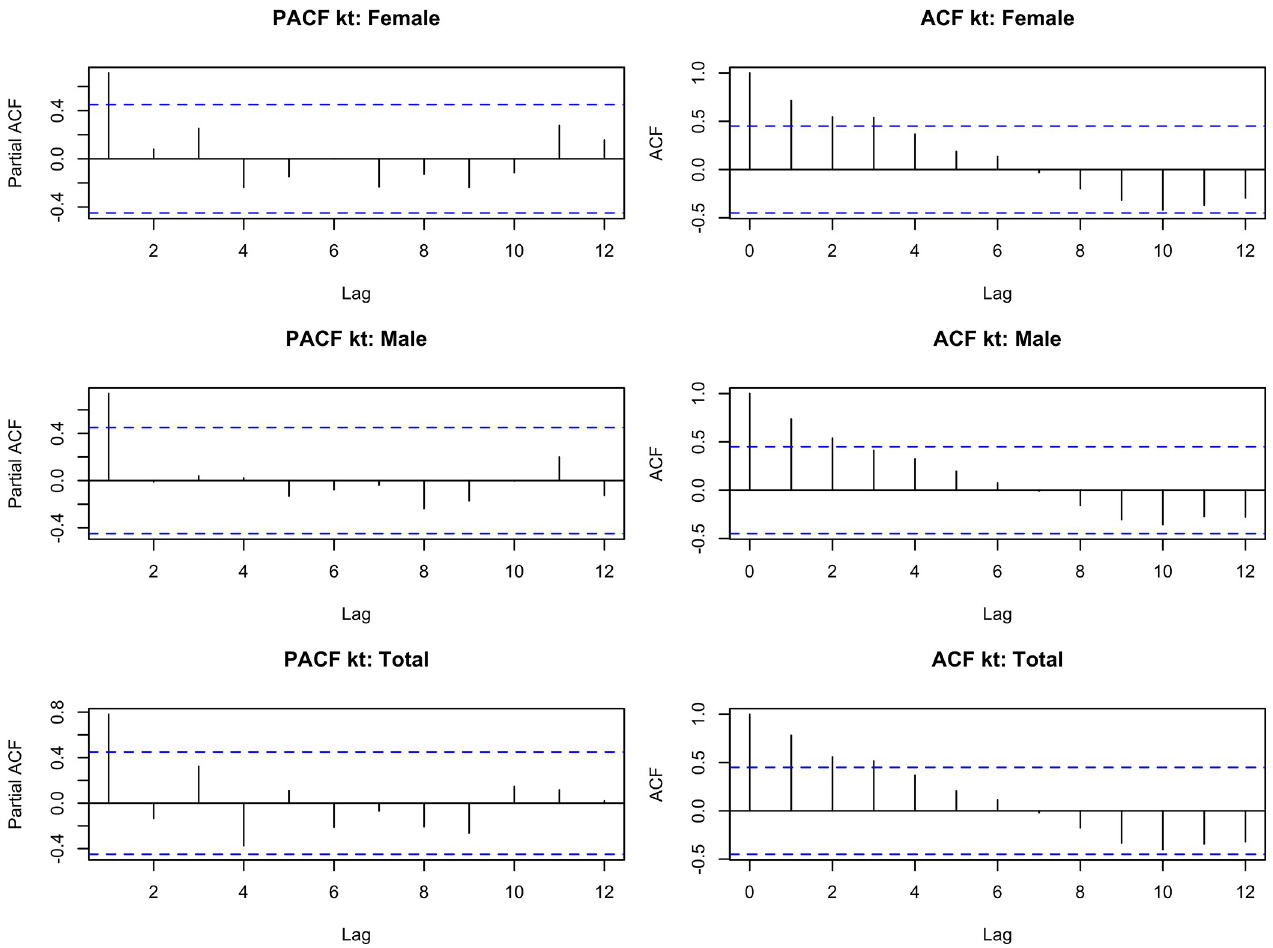
Fig 14. Partial autocorrelation function (PACF) and autocorrelation ACF) of kt estimated in the Lee-Carter model by sex.